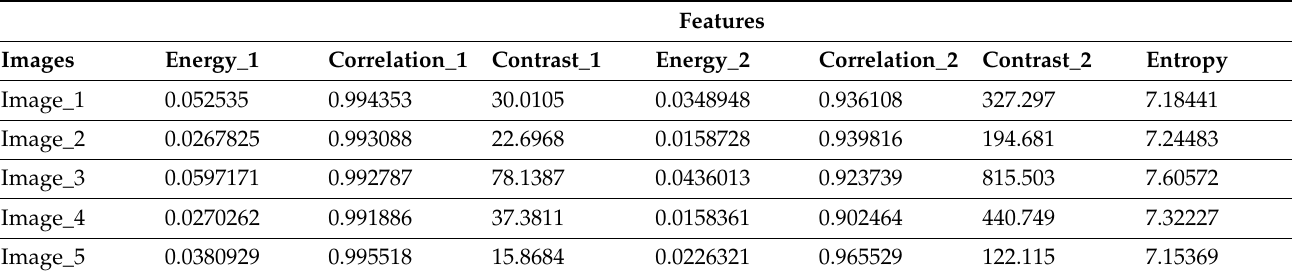
Table 3. Extracted features of some